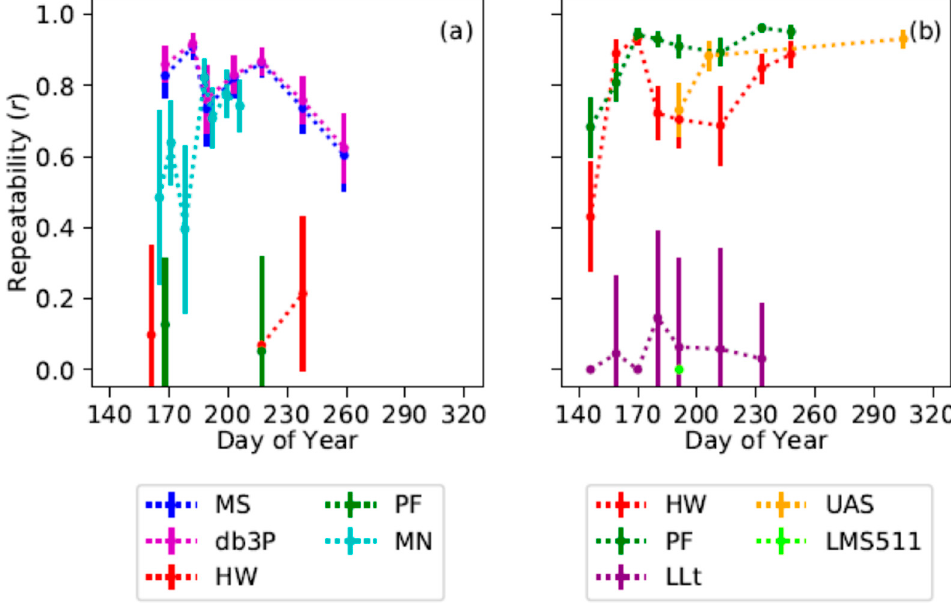
Figure 7. Estimated repeatability ( r ) for plant height measured using the Honeywell (HW), Pepperl+Fuchs (PF), MaxSonar (MS), db3 Pulsar (db3P), and manual measurements (MN) in 2016 ( a ); and the Honeywell (HW), Pepperl+Fuchs (PF), LidarLite v3 (LLt), unmanned aerial system images (UAS), and SICK-LMS511 (LMS511) sensors in 2017 ( b ) for each collection day.